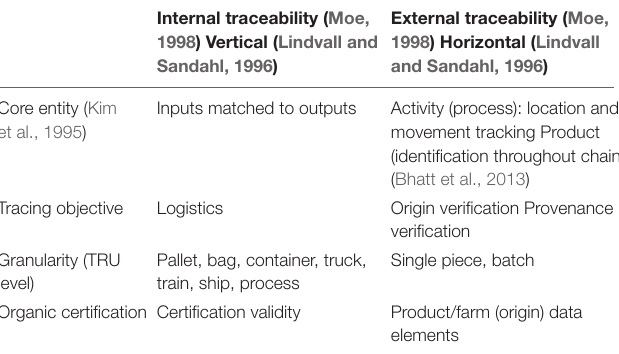
TABLE 1 | Organic traceability types, adapted from Moe (1998), Kim et al. (1995), and Bhatt et al. (2013). Internal traceability (Moe, External traceability (Moe, 1998) Vertical (Lindvall and 1998) Horizontal (Lindvall Sandahl, 1996) and Sandahl,